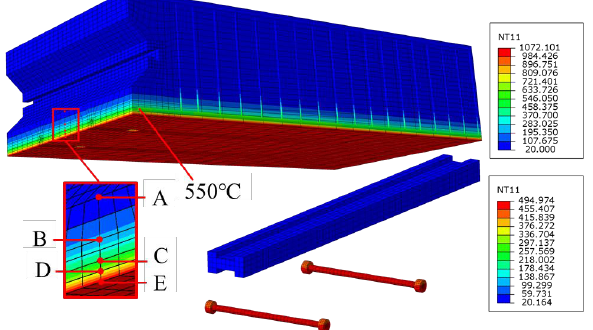
Figure 9. Cross-section temperature distributions after two hours of heating. According to the direction of the lining thickness, the temperature measuring points of A~E are selected, and the distance from them to the fire receiving surface is 0~200 mm. The trend curve of the temperature at different measuring points with time is obtained, as shown in Figure 10. When exposed to fire for 120 min, at a distance of 25 mm from the inner surface of the tunnel lining, the temperature is weakened to approximately 715 ◦ C. At a distance of 50 mm from the inner surface of the tunnel lining, the temperature is weakened to approximately 477 ◦ C. At a distance of 100 mm from the inner surface of the tunnel lining, the temperature is weakened to approximately 220 ◦ C, and at a position of 200 mm, the temperature is weakened to approximately 55 ◦ C. Figure 11 shows the temperatures of different measuring points when the joint is exposed to fire for 120 min. It can be seen from the figure that the temperature on the joint decreases rapidly with increasing distance from the inner surface of the tunnel. At a depth of 0 mm to 50 mm from the inner surface of the tunnel, the rate of temperature drop is linear, while at a depth of 50 mm to 200 mm from the inner surface of the tunnel, the rate of temperature drop gradually decreases. Figure 10. Temperature – time curves of concrete of various components of the model.